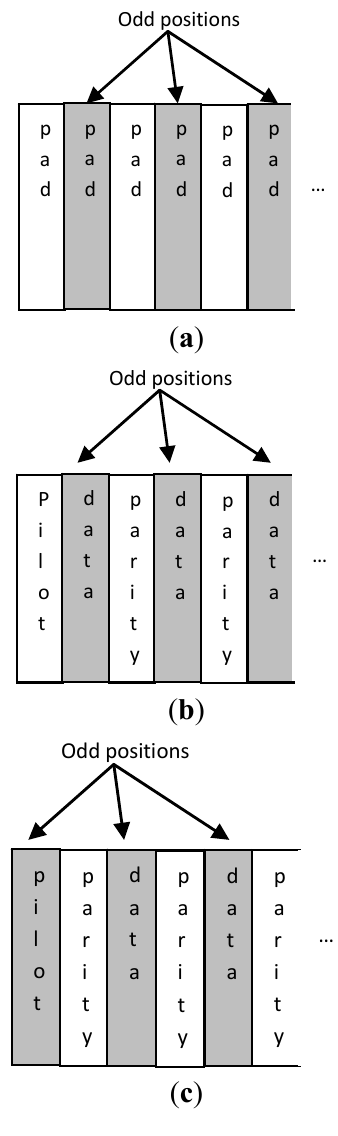
Figure 3. Order of ( a ) padding symbols, ( b ) parity and data symbols after a pilot at even position, and ( c ) parity and data symbols after a pilot at odd